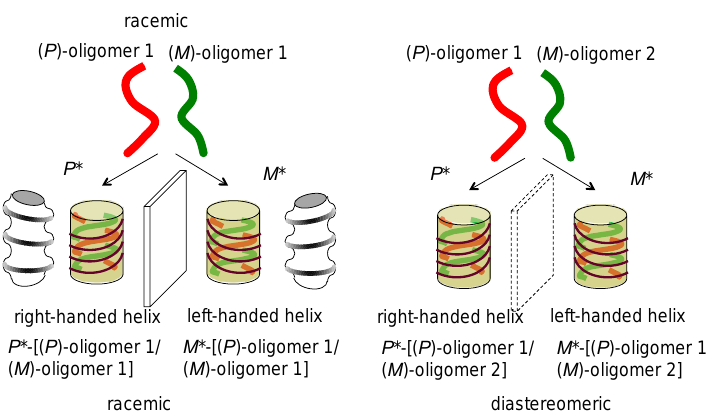
Figure 6. Hetero-double-helix chiral cylindrical molecular complexes with enantiomeric three-dimensional structures, which are derived from racemic oligomers providing enantiomeric structures and from slightly different structures of oligomers providing diastereomeric structures. Hetero-double-helixes are shown in transparent yellow.